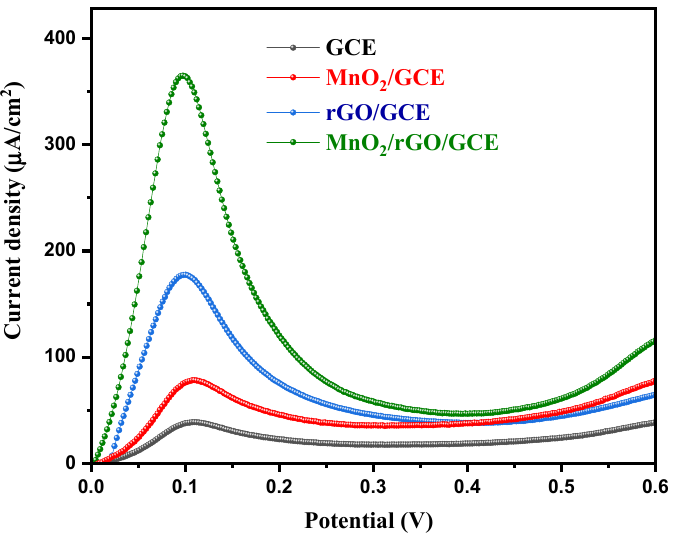
Figure 6. LSV of GCE, MnO 2 /GCE, rGO/GCE and MnO 2 /rGO/GCE in 50 µM 4-NP (PBS = 0.1 M; pH = 7.0; scan rate = 50 mV/s).